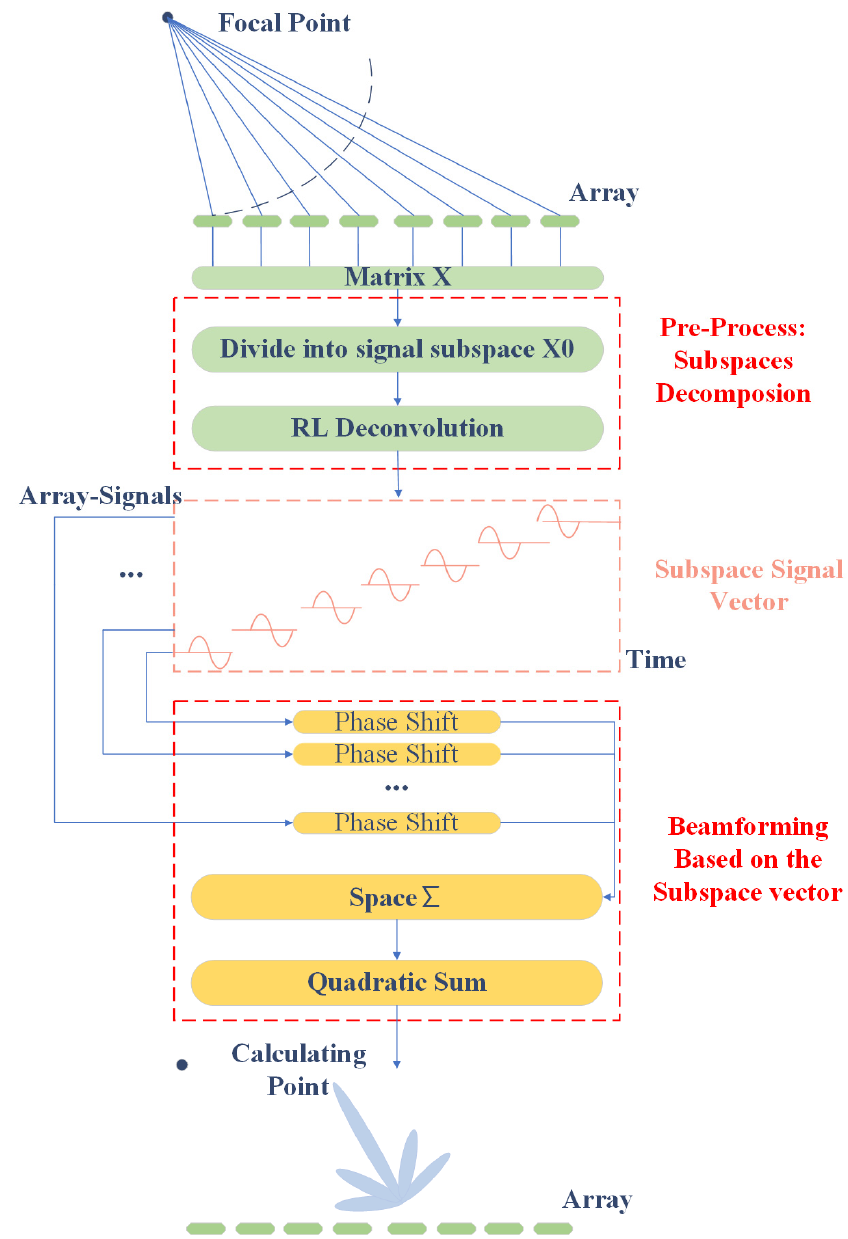
Figure 1. Flow chart of SDV method.